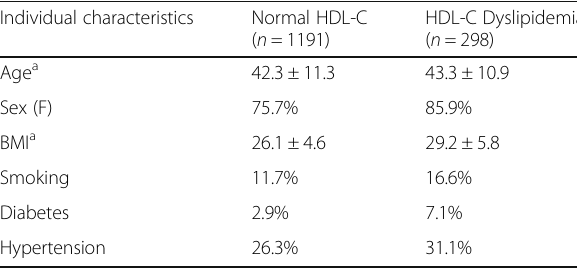
Table 1 Individual characteristics of CODING study with/ without HDL-C dyslipidemia Individual